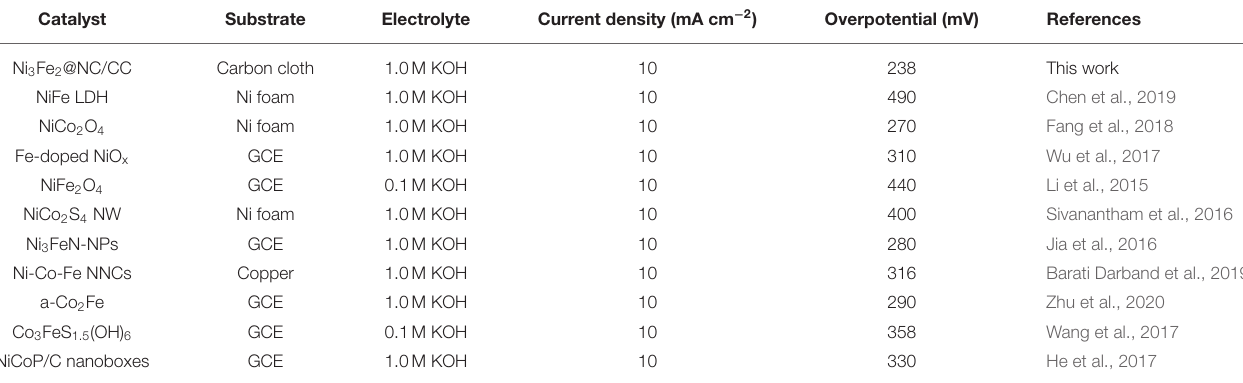
TABLE 1 | The OER performance of the recently reported highly active catalysts. Catalyst Substrate Electrolyte Current density (mA cm − 2 ) Overpotential